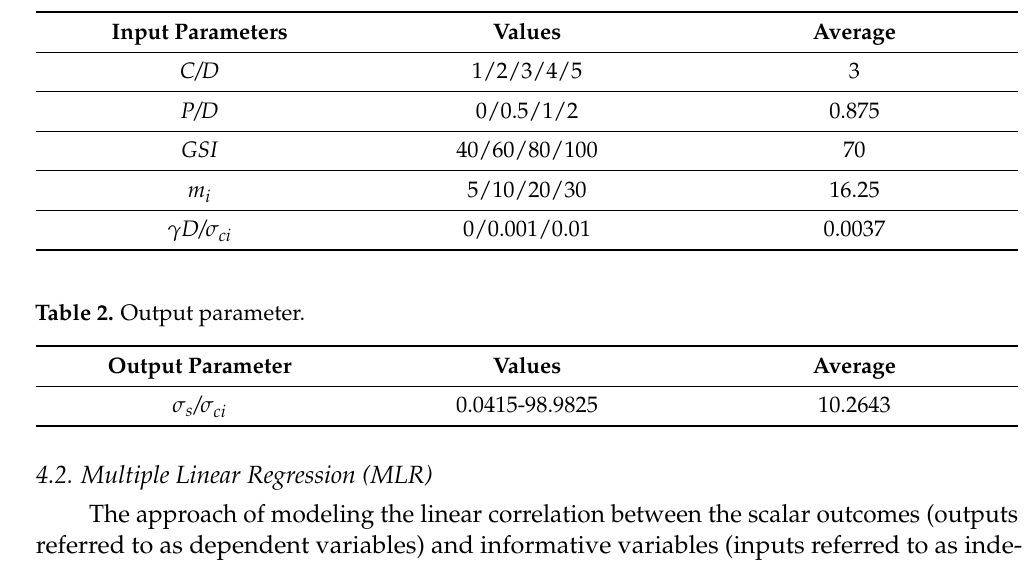
Table 1. Input parameters.